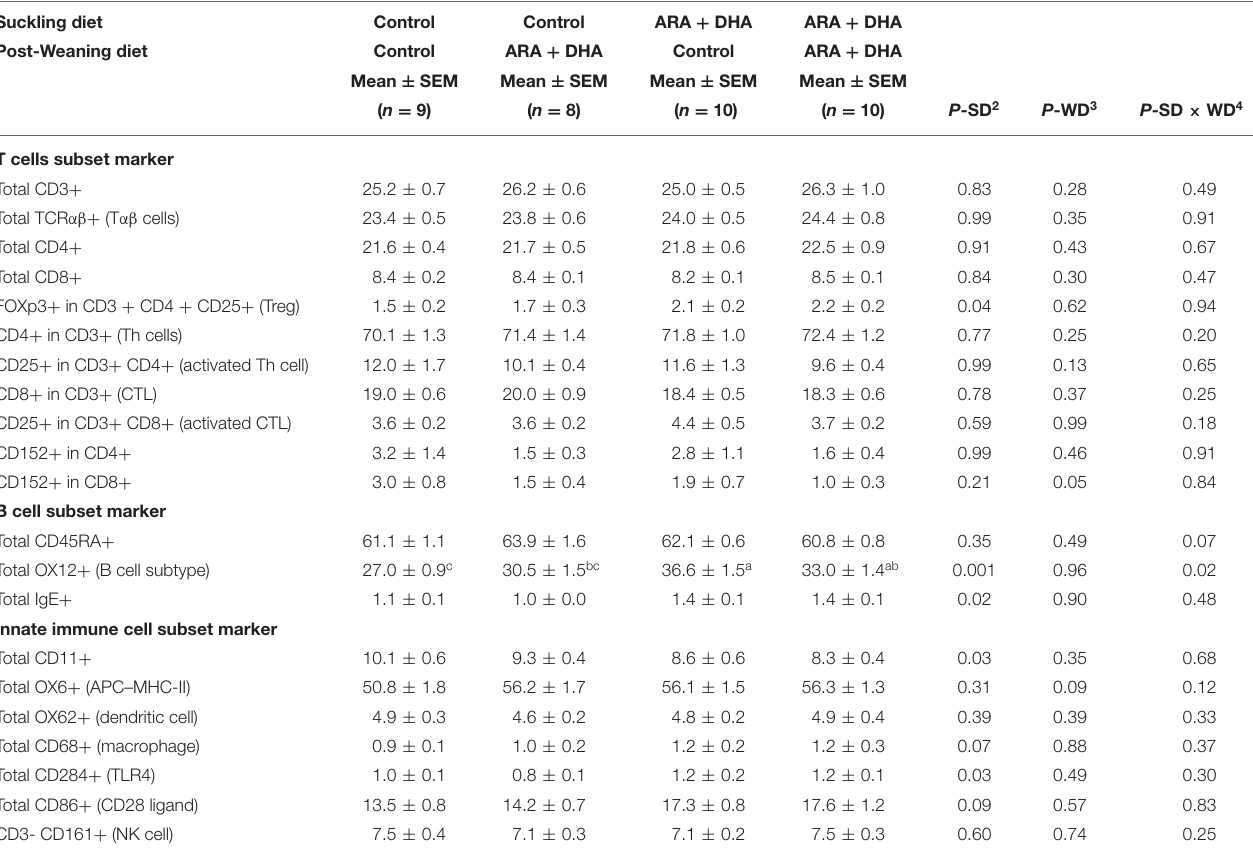
TABLE 4 | The effect of supplementing suckling diet and post-weaning diet on the composition of immune cell types isolated from the spleen of 8-week-old Brown Norway offspring 1 . Suckling diet Control Control ARA + DHA ARA + DHA Post-Weaning diet